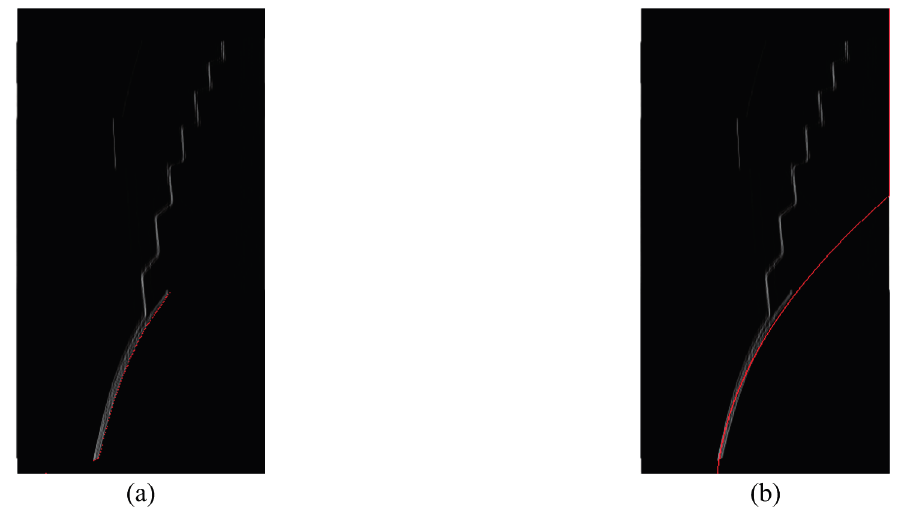
Figure 6. The ground curve in V disparity map. ( a ) Segment consisting of points (red); ( b ) The line of the equation (red). 2